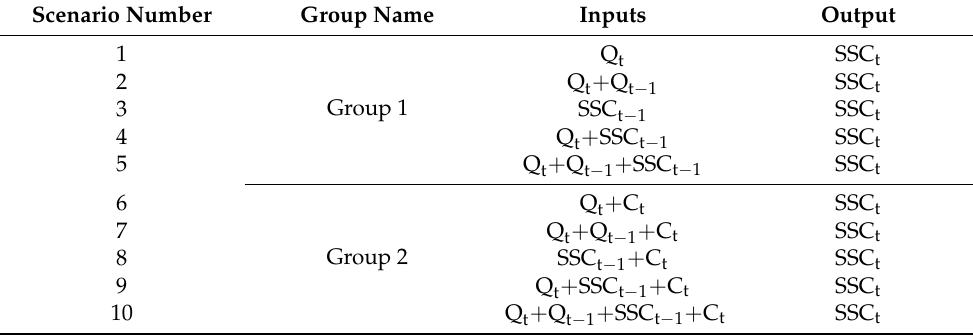
Table 2. Input and output